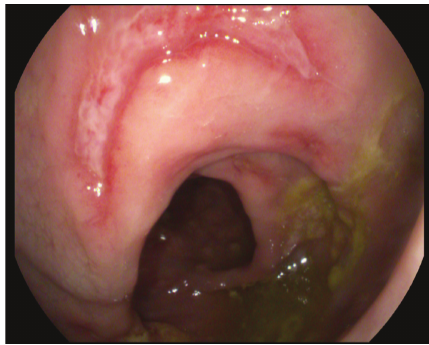
Figure 2: A single ulcer with regular edges and a lunate shape, occupying one-third of the visceral circumference.